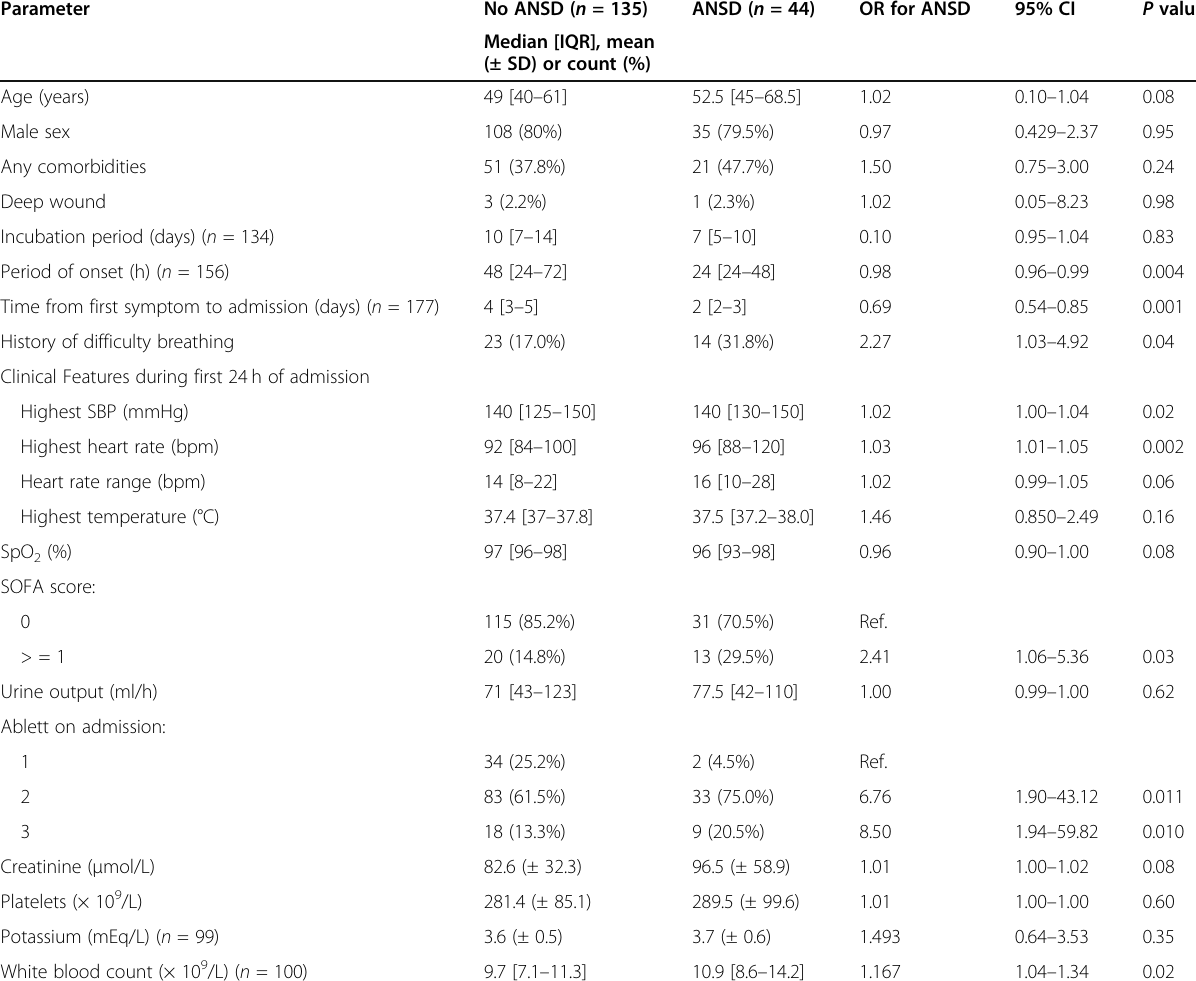
Table 3 Tetanus risk factors for development of ANSD ( n = 179)